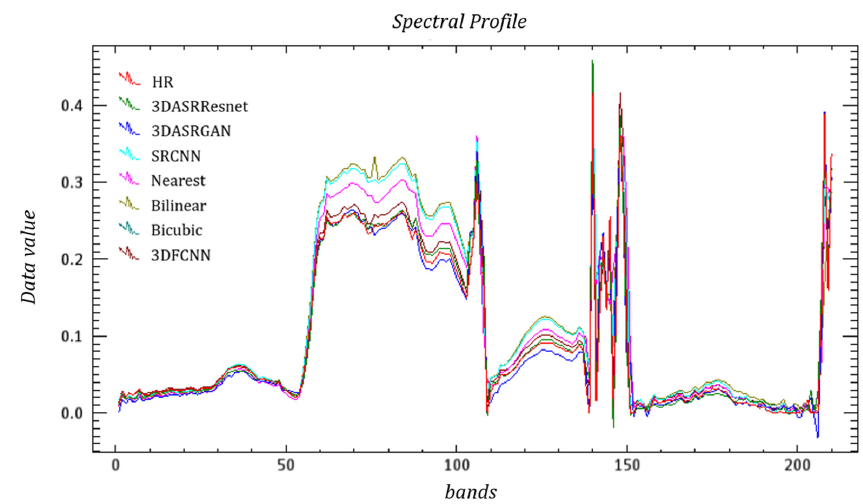
Figure 11. Example Spectral Curves of Roads based on the Washington DC Mall dataset.